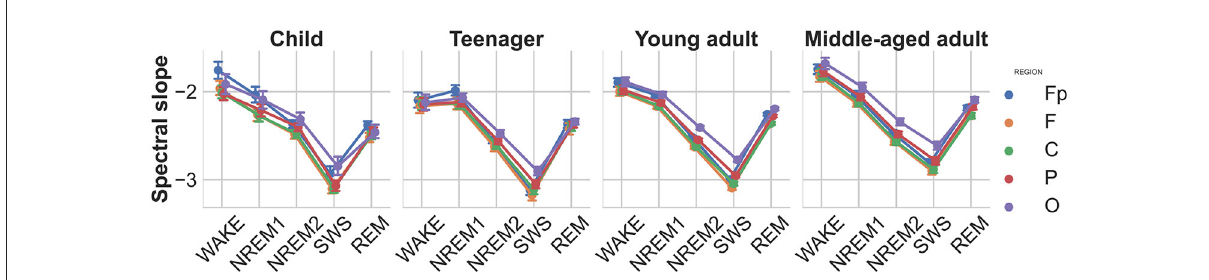
FIGURE2 Spectral slopes as functions of sleep stage, brain region, and age group. Note the gradual decrease of slope values (decreasing spectral exponents, increasing steepness) during the course of deepening of NREM sleep, as well as a relatively increased slope in REM sleep (but still below the NREM1 values). Vertical bars denote 95% confidence